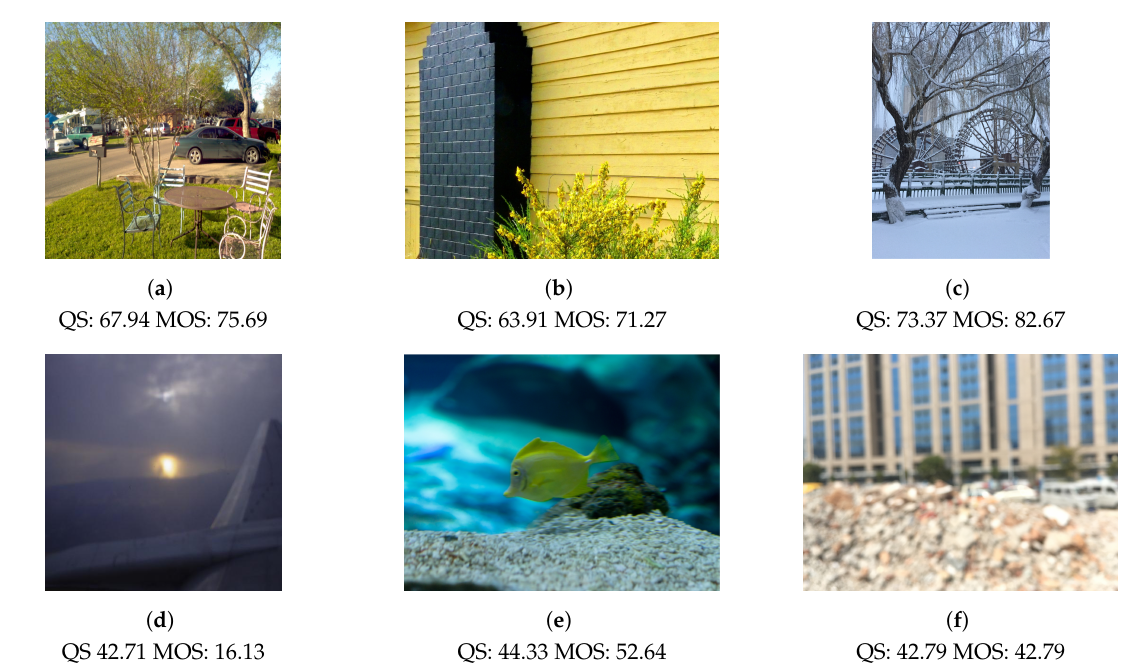
Figure 9. Examples of predicted quality score (QS) alongside the mean opinion score (MOS). First column images ( a , d ) belong to LIVE-itW database, second column picures ( b , e ) are from KONIQ dataset while the last column photos ( c , f ) belong to the SPAQ collection. Table 5. SROCC, PLCC, AUC and AUPR of the proposed solution alongside the average intra-layer correlation (MEAN_GM) and the abnormality score for the databases LIVE-itW, KONIQ and SPAQ. For each database, in each column, the best values are marked in